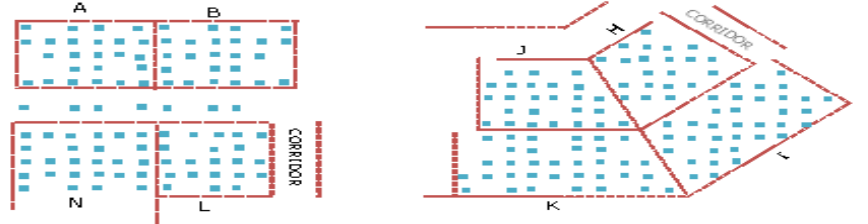
Figure 5. Points with known position were used to verify the accuracy achievement of the neural network results.